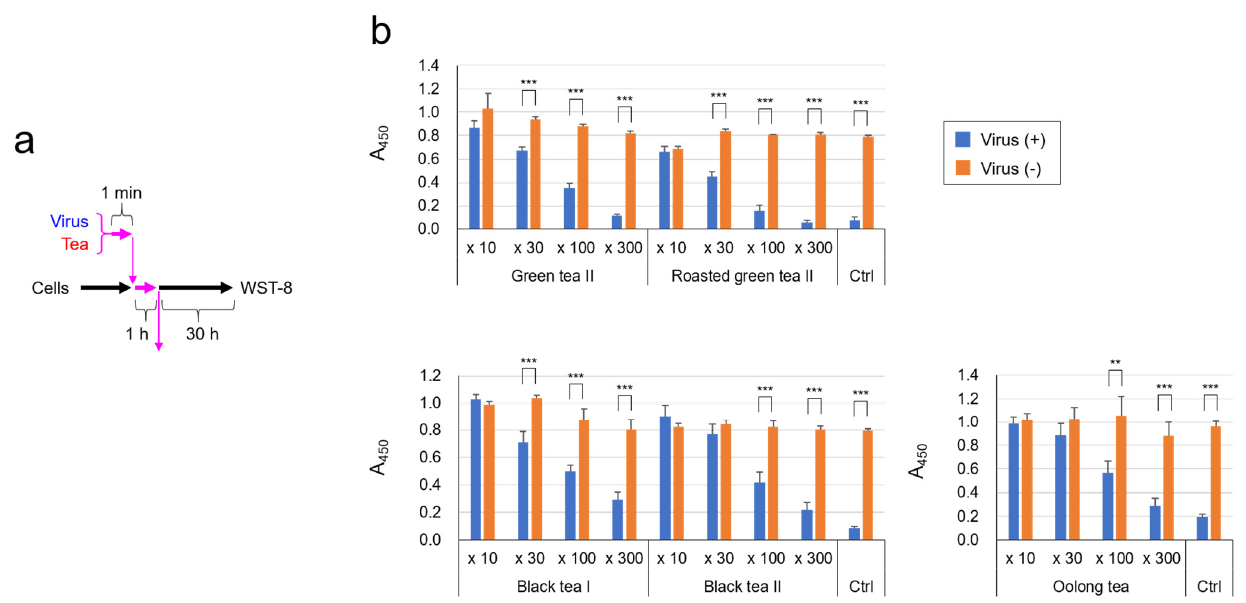
Figure 2. Viability of VeroE6/TMPRSS2 cells after infection with SARS-CoV-2 treated with tea. Virus was treated with each tea at the indicated dilutions for 1 min, and the virus/tea/DMEM mixture was added to VeroE6/TMPRSS2 cells at MOI = 3 for 1 h. After removal of the supernatant, cells were cultured in fresh MS for 30 h, followed by cell viability determination as described in the Materials and Methods. Scheme of experiments ( a ) and A450 value of each sample ( b ) are shown. Values are means ± S.D. ( n = 3). ** p < 0.01 and *** p < 0.001 between groups by Student’s t test.